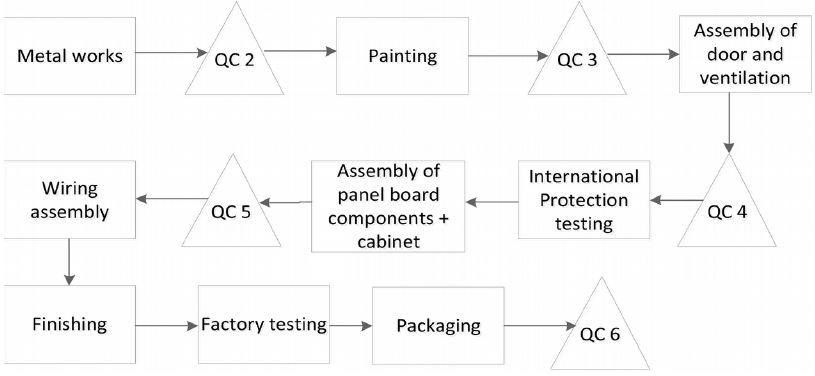
Figure 4. Switchboard Fabrication